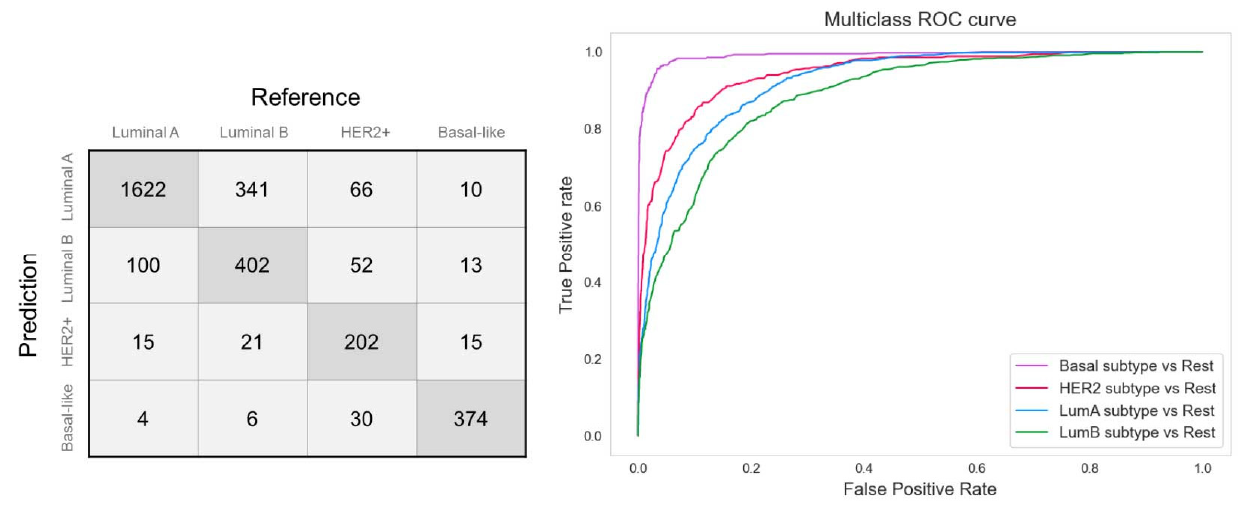
Figure 5. Confusion matrix for breast cancer molecular subtype predictor based on expression of PUFA genes.